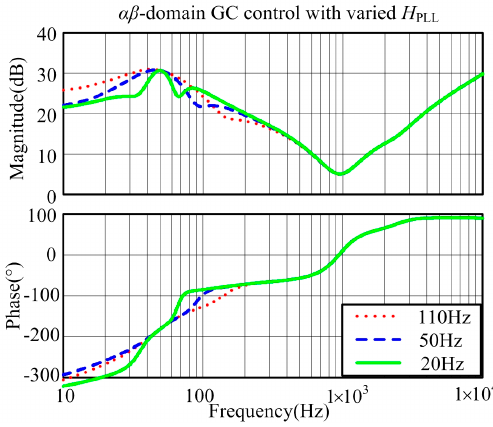
Figure 13. Impedance response with different PLL controller parameters.